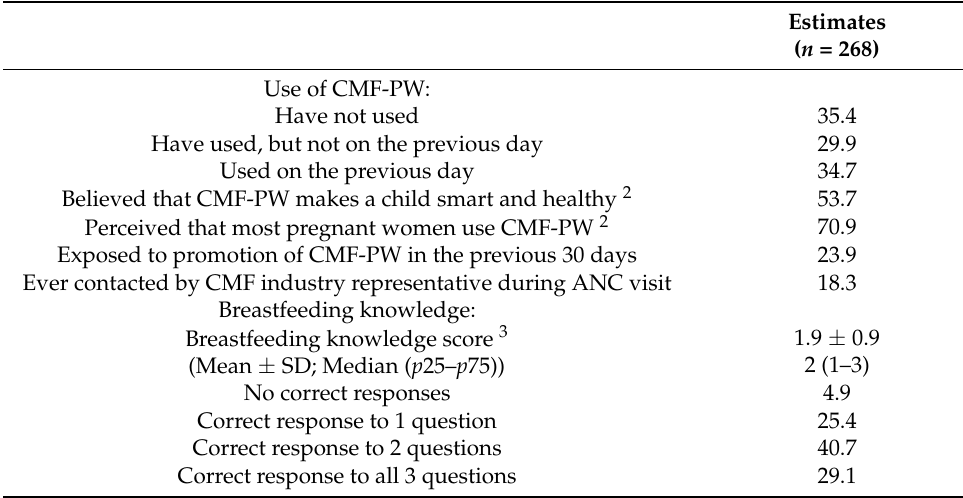
Table 2. Use of commercial milk formula for pregnant women (CMF-PW), exposure to promotion of CMF-PW and breastfeeding knowledge 1